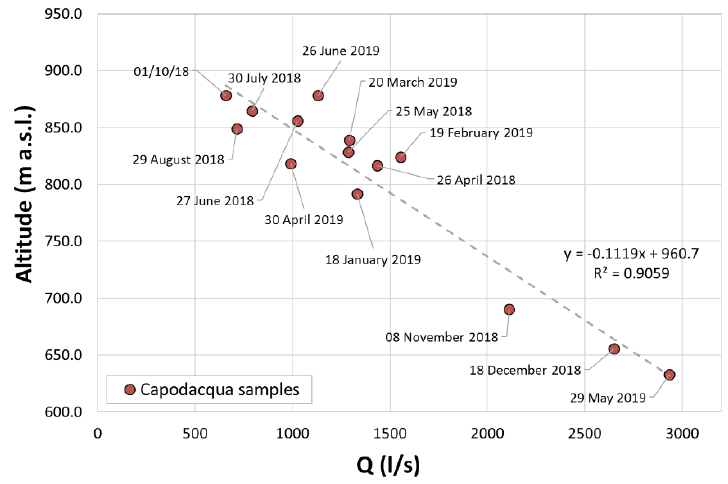
Figure 5. Discharges supplied by Capodacqua di Sprigno Spring in relation to average recharge area elevations, obtained using oxygen-18 and deuterium isotopes.